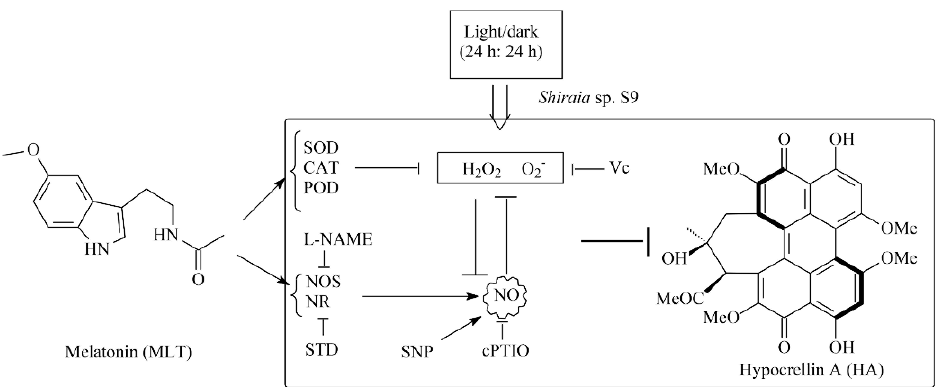
Figure 8. A simplified model for the inhibition of hyprocrellin A (HA) by melatonin (MLT). Black lines with arrows indicate promotion of pathway or expression, and lines with blocked ends indicate inhibition of pathway or expression.